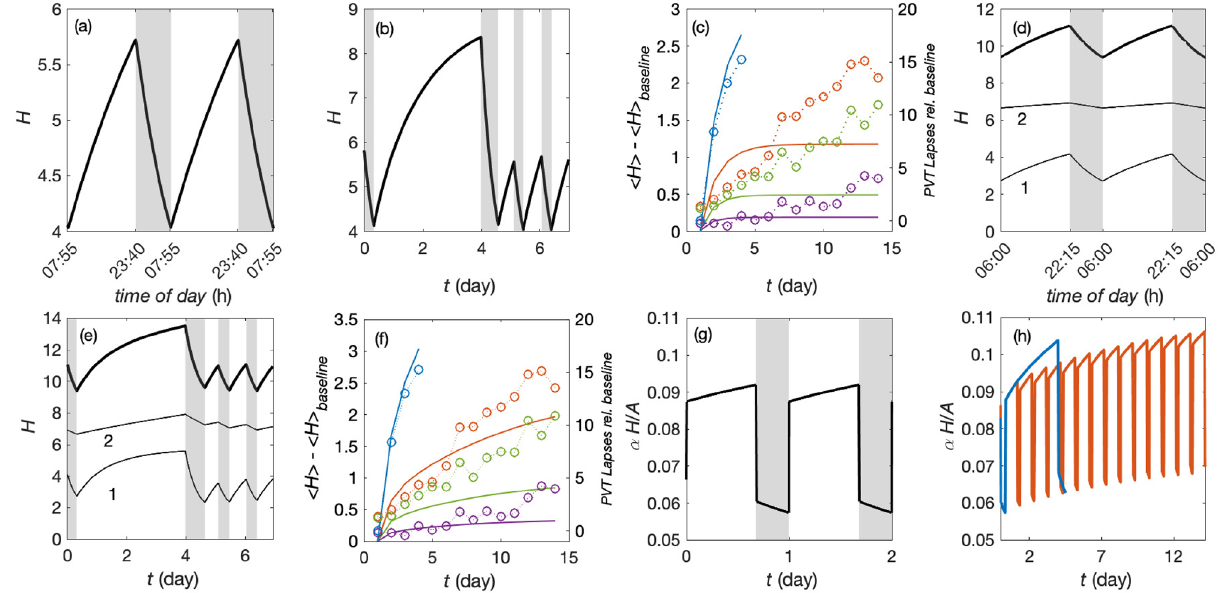
Figure 3. One and two species dynamics of H and void blocking fraction for the best-fit parameters in Table 1 for the calibration experiments. One species dynamics for ( a ) normal sleep; ( b ) sleep deprivation; and ( c ) chronic sleep restriction, cycle-averaged and normalized to the baseline days with blue showing sleep deprivation, orange 4 h sleep opportunity, green 6 h, and purple 8 h. Two species dynamics for ( d ) normal sleep, ( e ) sleep deprivation, ( f ) chronic sleep restriction, cycle-averaged and normalized to the baseline days, plotted as in ( c ). Open symbols show PVT lapse data from Van Dongen et al.’s 23 study. Void blockage fraction for two species: ( g ) during normal sleep-wake cycles, and ( h ) during chronic sleep restriction from 23 . Blue, red, green, and purple indicate sleep deprivation, 4, 6, and 8 h sleep opportunity per day,